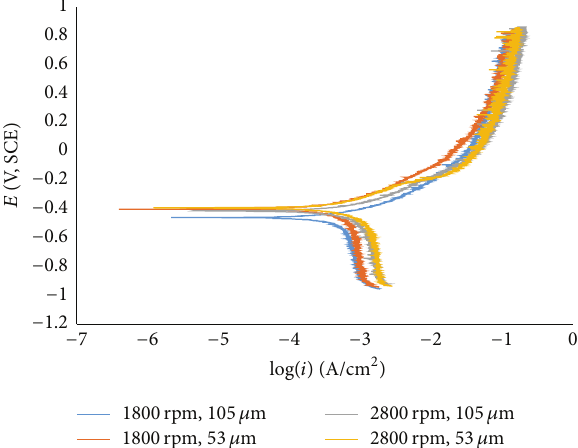
Figure 6: Potentiodynamic polarization curves of AISI 4330 steel electrode at different rotating speeds and particle sizes in pH 3 solutions containing 3wt.% NaCl with a constant concentration of 10 wt.% silica particles in deionized